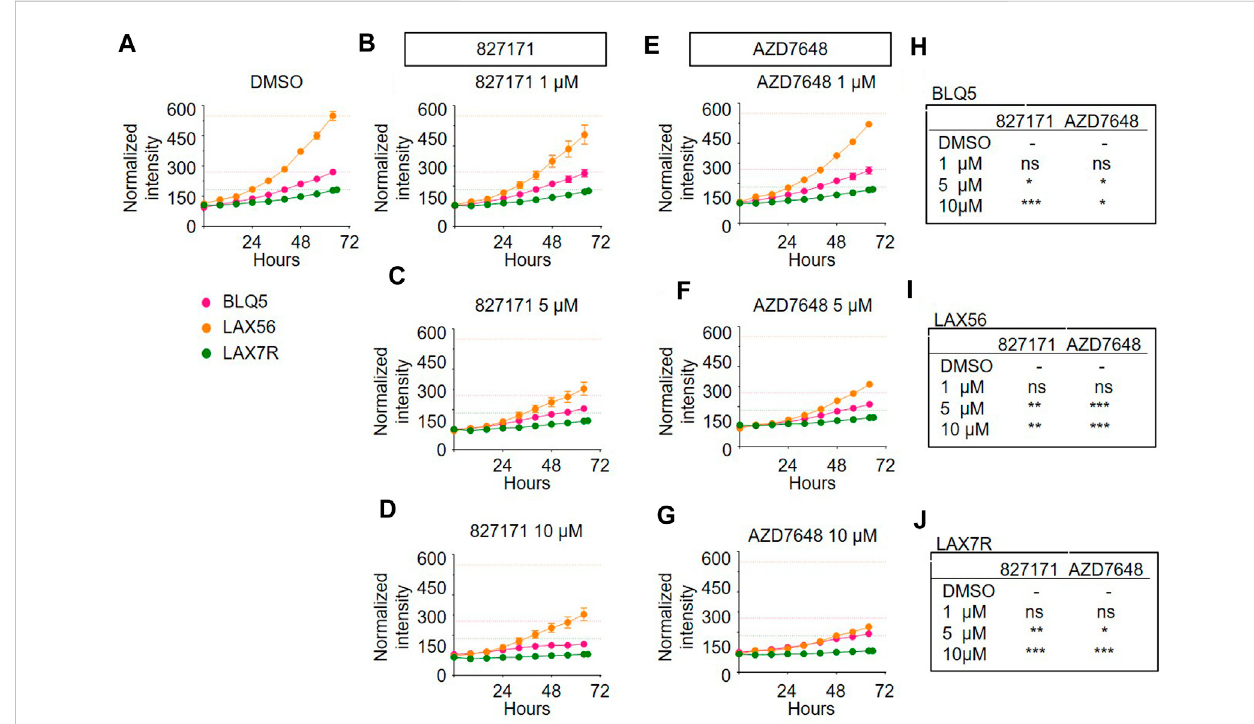
FIGURE 5 The Artemis inhibitor 827171 and DNA-PK inhibitor AZD7648 substantially inhibit proliferation of B-ALL. Primary B-ALL cells (BLQ5, LAX56, and LAX7R) were transduced with GFP, and 100,000 cells were plated in 24-well plates seeded with irradiated OP9 cells. Cells were treated with DMSO control (A) , Artemis inhibitor 827171 (B – D) or DNA-PK inhibitor AZD7648 (E – G) with the indicated doses. Green fl uorescence intensity was measured by Incucyte every 8 h. Raw values werenormalized to the0 hDMSO control. The dashed lines indicate the meanof the fi nal time point measurements of the DMSO control for each primary B-ALL cell. The statistical analysis of proliferation differences is shown for the fi nal time point measurements for BLQ5 (H) , LAX56 (I) , LAX7R (J) , after treatment with 827171 or DNA-PK inhibitor AZD7648 at indicated doses compared to DMSO control. ns: non- signi fi cant. * p < 0.05; ** p < 0.001; *** p < 0.0001, one-way